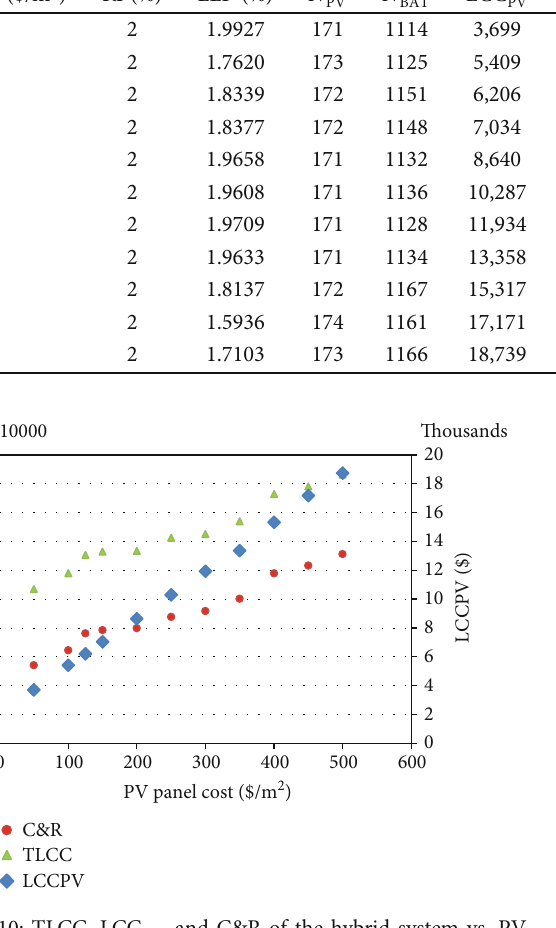
Table 3: The results of the variations of the PV panel unit cost on the optimal variables and cost criteria (in $) of the system. PV cost ($/m 2